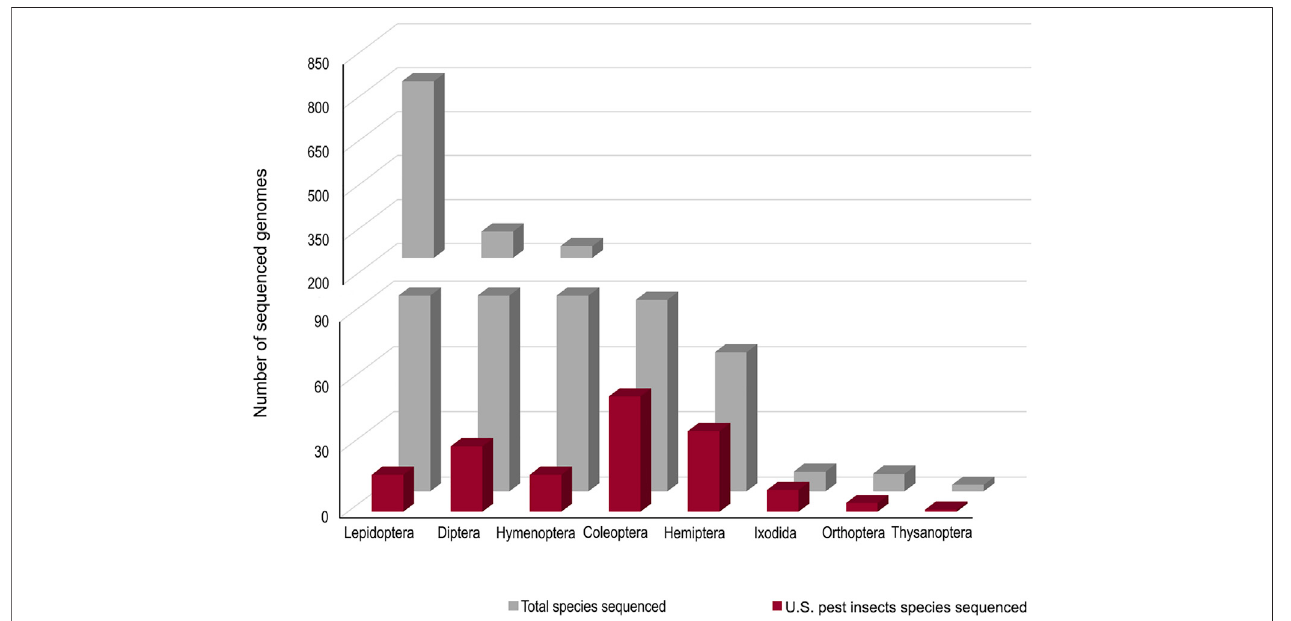
FIGURE 2 | The number of genome projects for each species within each insect order based on depositions at the NCBI(all species) and at the i5K project (http:// i5k.github.io/about). Data as at 2022.